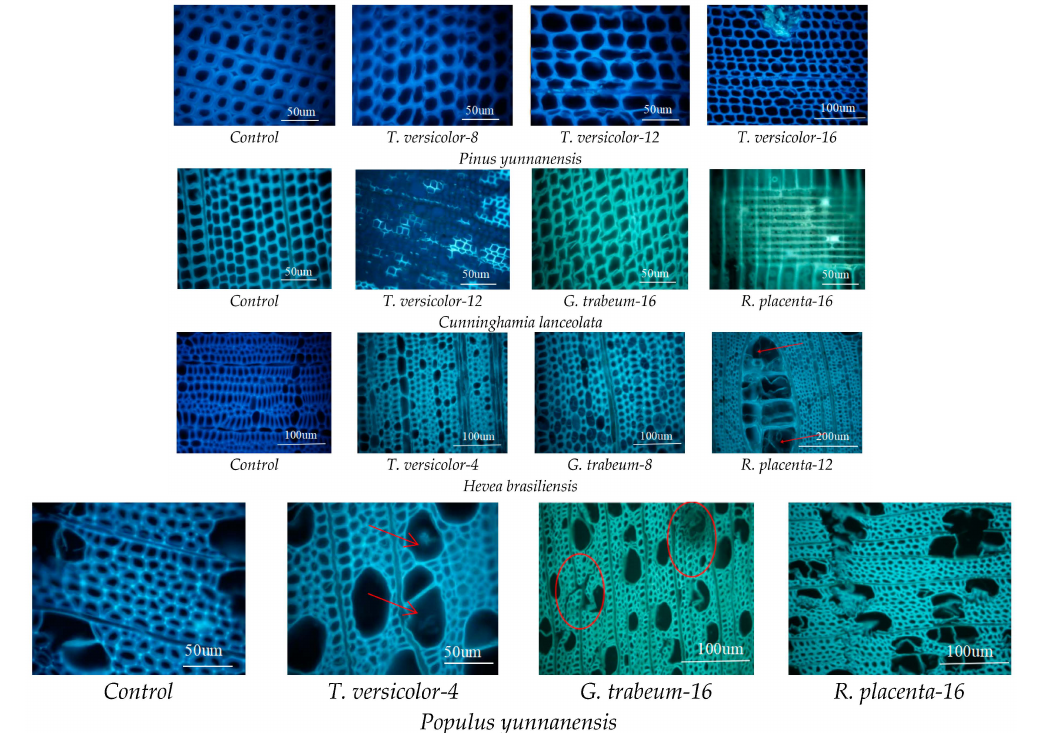
Figure 4. Light microscopy images of wood samples biodegraded by different fungi.